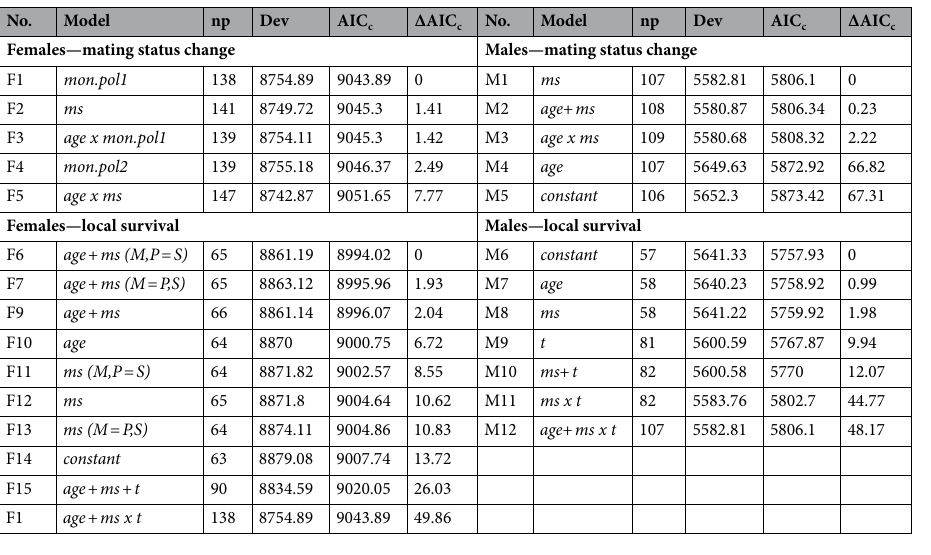
Table 1. Model selection for mating status change and local survival probabilities. For each model, the deviance, the number of estimable parameters ( np ), the Akaike Information Criterion corrected for small sample sizes (AIC c ), and the difference in AIC c between the current model and best model with the lowest AIC c of the current parameter (ΔAIC c ) are shown. For other parameters, see Table S1 for model selection. Model notation: +, additive relationship, x , non-additive relationship, ms , different P of change from one mating status to another or a different survival P for each mating status, mon.pol1 , is a set of three constrained probabilties: (i) same P of change from "mon to prim" and "mon to sec", (ii) same P of change from "prim to prim" and "sec to sec", and (iii) same P of change from "prim to sec" and "sec to prim", mon.pol2 , like mon.pol1 but different P of “prim to sec” and “sec to prim”, ms (M,P = S) , same survival P of prim and sec, but different from mon females, ms (M = P,S) , same survival P of mon and prim, but distinct from sec females, t , time; constant , no effect, age , two-classes age effect (1-yo; >